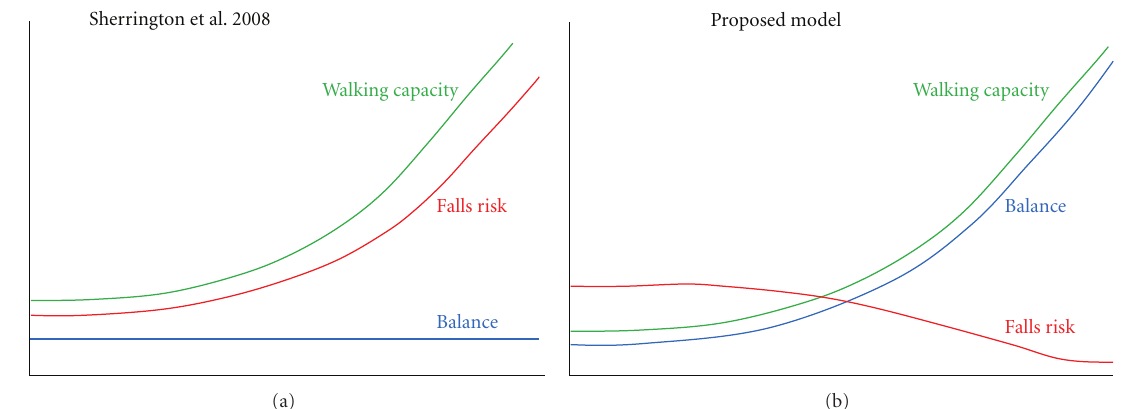
Figure 1: (a) Illustration of Sherrington et al.’s [41] conclusion of increased risk of falls if no balance intervention is supplied and walking capacity increases and (b) a theoretical depiction of combined e ff ects of walking capacity with balance training on falls